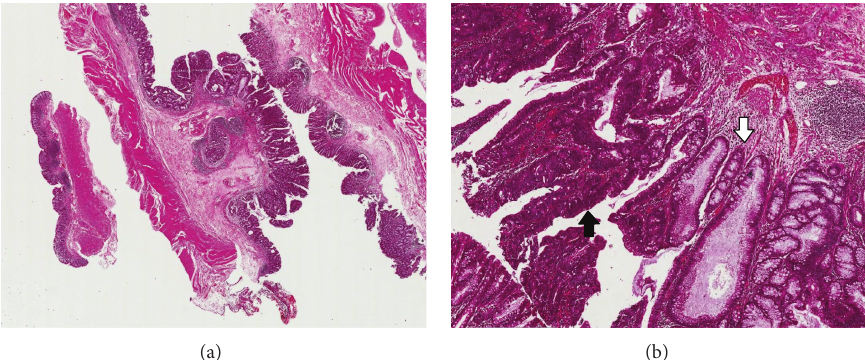
Figure 3: (a) The traditional sessile serrated adenoma of the appendix. (b) The intramucosal adenocarcinoma (black arrow) arising in the traditional sessile serrated adenoma (white